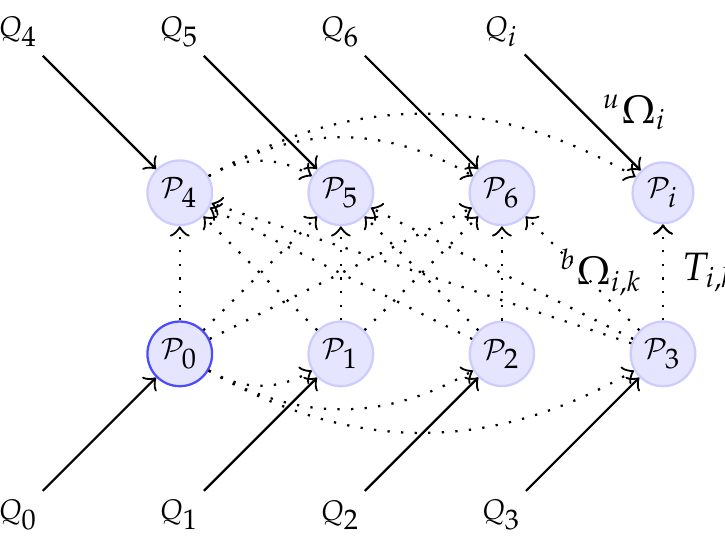
Figure 4. Pose graph for fusion problem. u Ω i and b Ω i , k are the information matrices for unary and binary edges respectively. P 0 represents the origin of the marker map, G ( 0,0,0 )